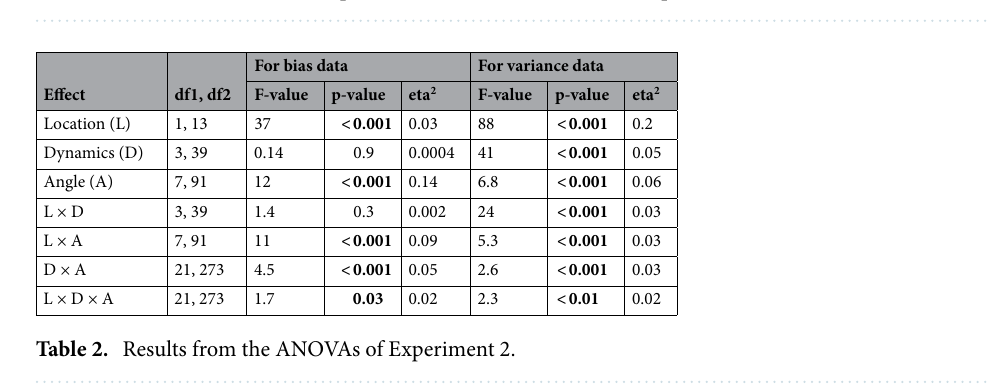
Figure 3. Results of Experiment 2. (A) The average rate of the stimulus orientation reported by the participants. (B) The bias and variance of the reported orientation. The error bars represent 95% CIs.